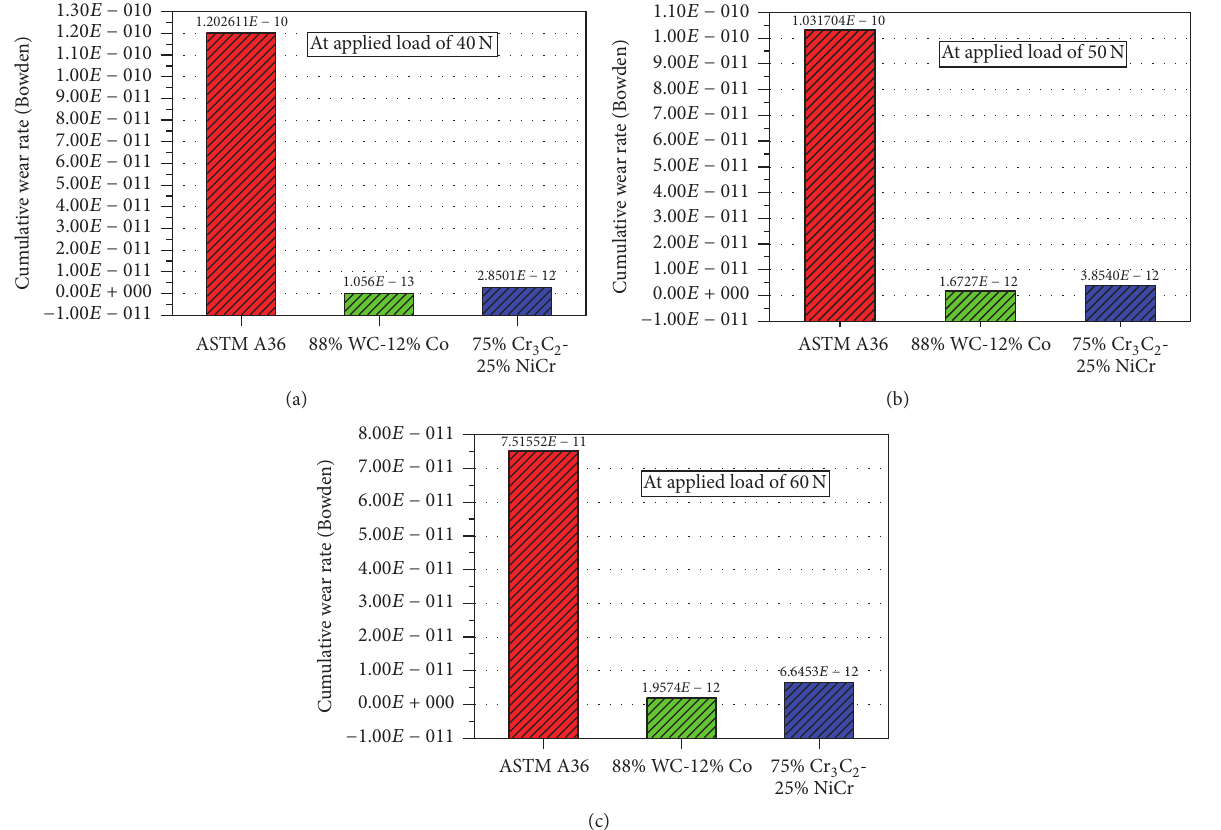
Figure 7: Bar chart showing C.W.R. for uncoated (bare) and D-Gun sprayed coated ASTM A36 steel at normal applied load of (a) 40 N; (b) 50 N; (c) 60 N at a sliding velocity of 2 ms −1 , after a sliding distance of 10,800 m.